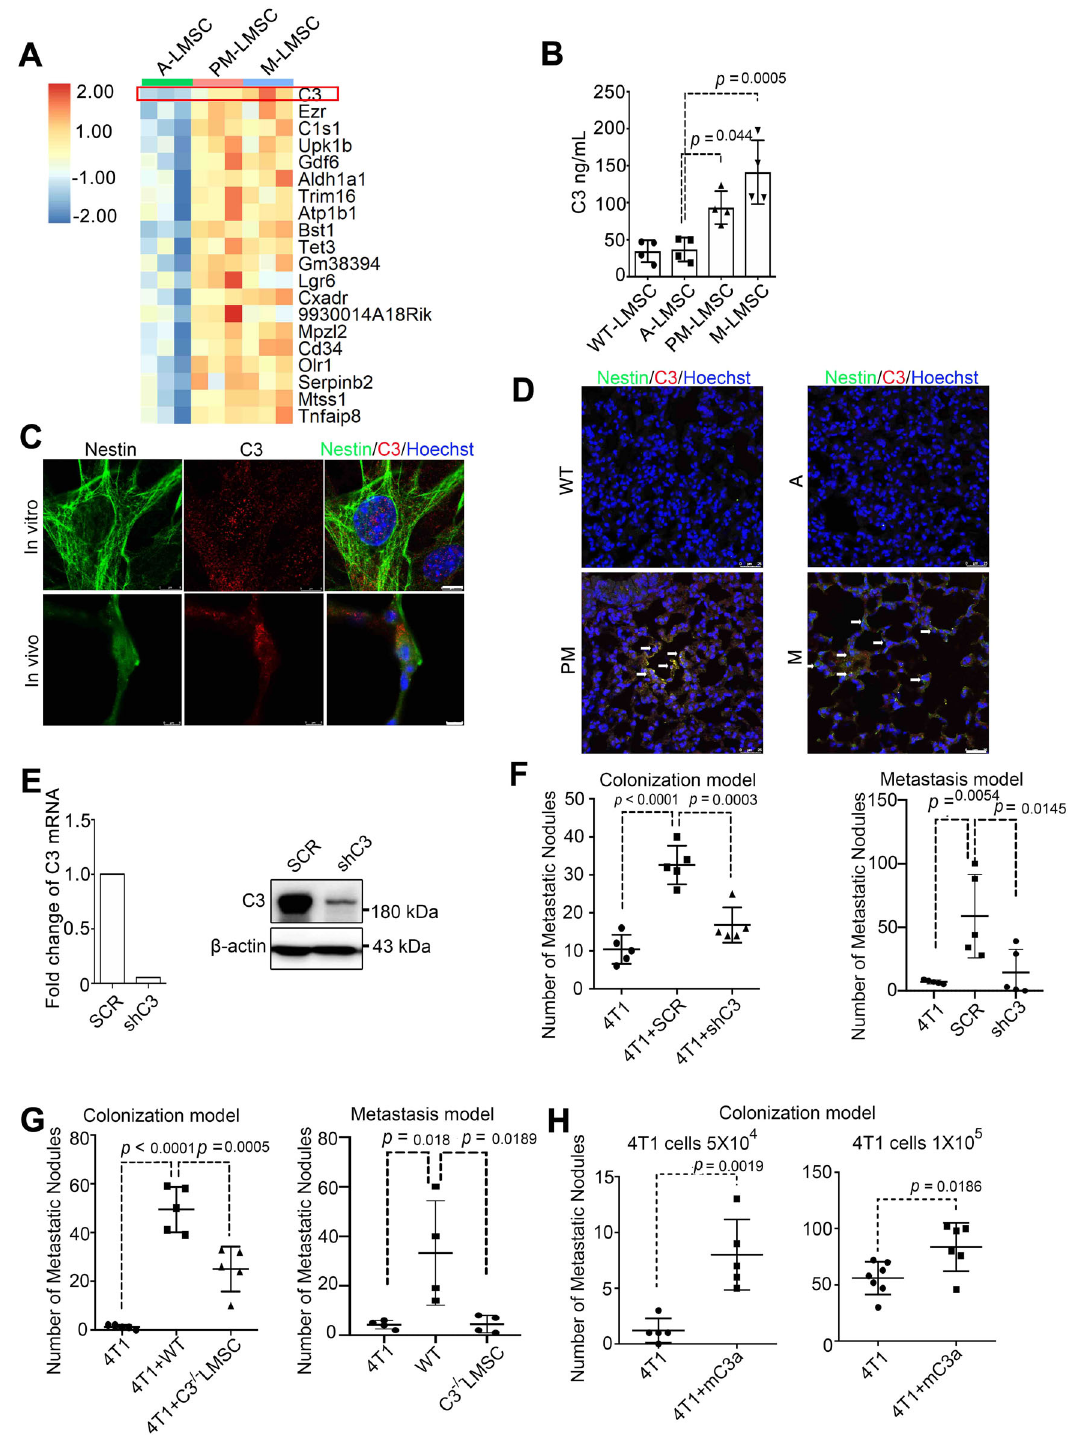
metastasis-promoting effects of the LMSCs in MMTV-pyMT mice, we analyzed the gene expression pro fi les in LMSCs by RNA-sequencing (RNA-seq) (Supplementary Fig. 2A). Top 20 genes that were upregulated in PM- and M-LMSCs, shown in Fig. 2A, included complement C3, a central protein in the com- plement system. The elevation in the expression of C3 was con- fi rmed using quantiative PCR (Supplementary Fig. 2B). The C3 upregulation in PM- and M-LMSCs in comparison to WT- and A-LMSCs was further con fi rmed at the protein level, as